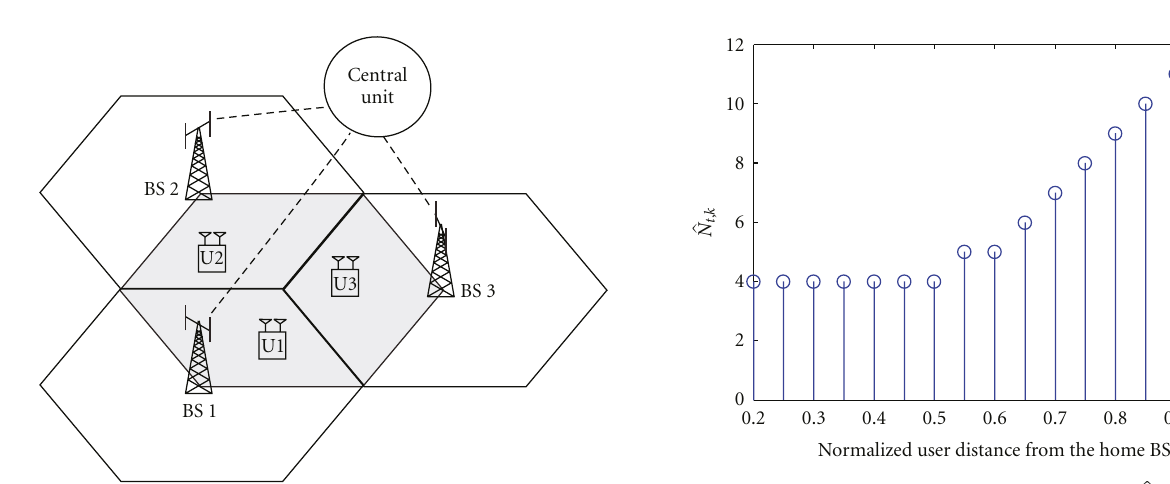
to one random snapshot of user locations when for any given L and (cid:4) k other users are assigned with 1 or 2 data streams. It is also assumed that no user is within a normalized distance of 0.2 from its closest BS for the pathloss model to be valid.